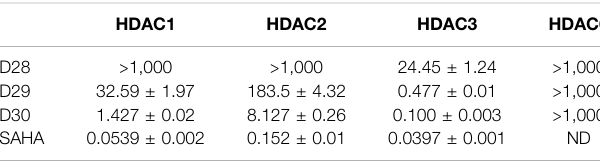
TABLE 2 | Enzyme inhibitory selectivity of representative compounds compared with SAHA (IC 50 , µM a